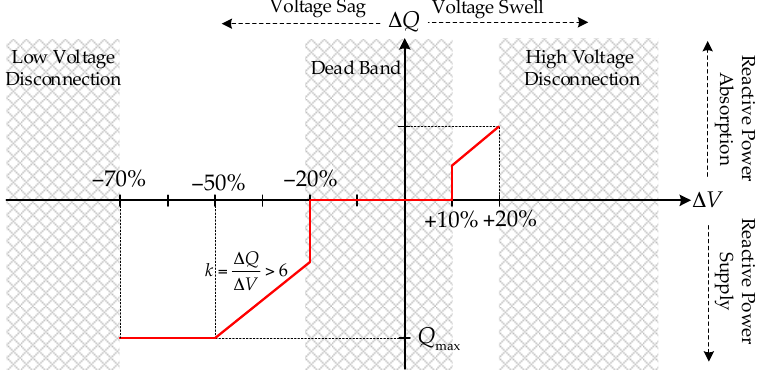
Figure 2. Reactive power support capability.